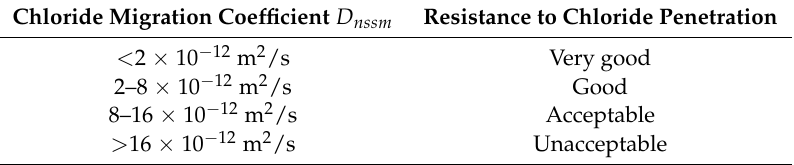
Table 3. Criteria for the classification of the concrete resistance to chloride ions’ penetration